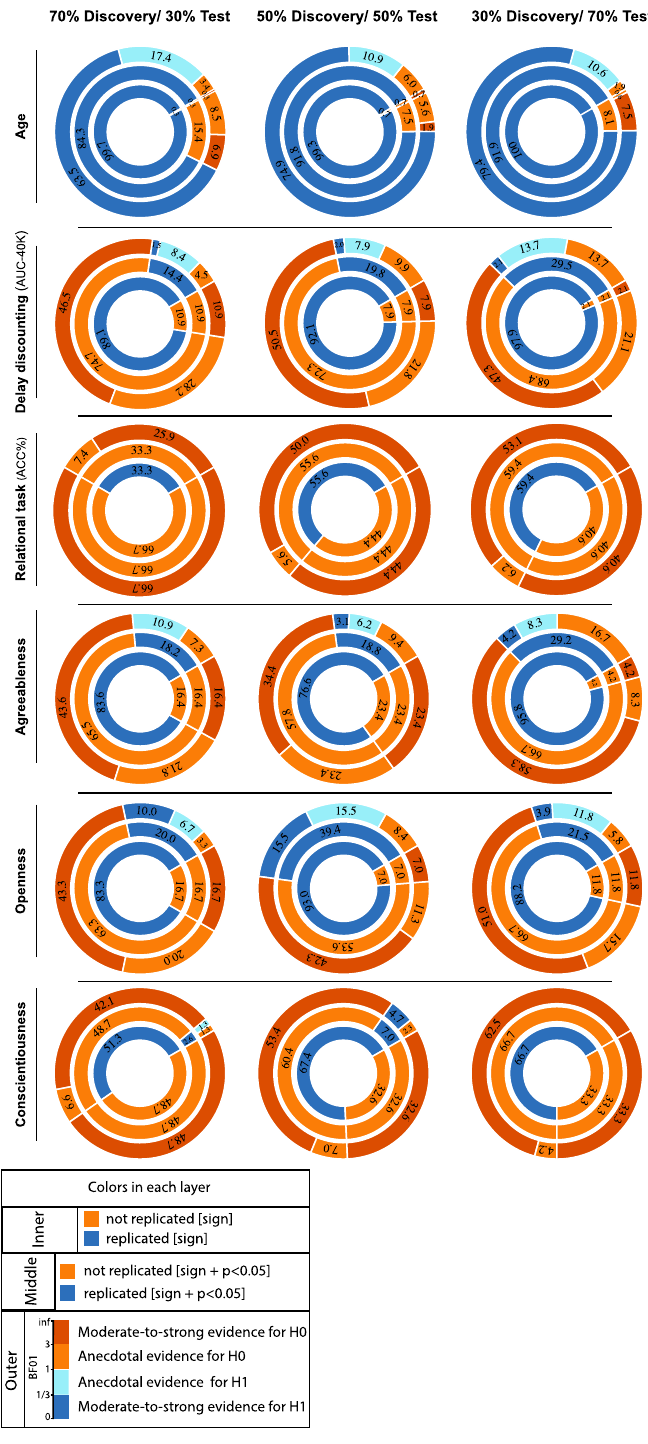
Figure 2. ROI-based confirmatory replication results. Donut plots summerising ROI-based replication rates (% of ROI) using three different critera for three different sample sizes among heathy participants. The most inner layers depict replication using “sign” only (blue: replicated, orange: not replciated). The middle layers define replication based on similar “sign” as well as “statistical significance” (i.e. p < 0.05) (blue: replicated, orange: not replciate). The most outer layers define replication using “bayes factor” (blue: “moderate-to-string evidece for H1, light blue: anecdotal evidence for H1; light orange: anecdotal evidence for H0, orange: “moderate-to-string evidece for